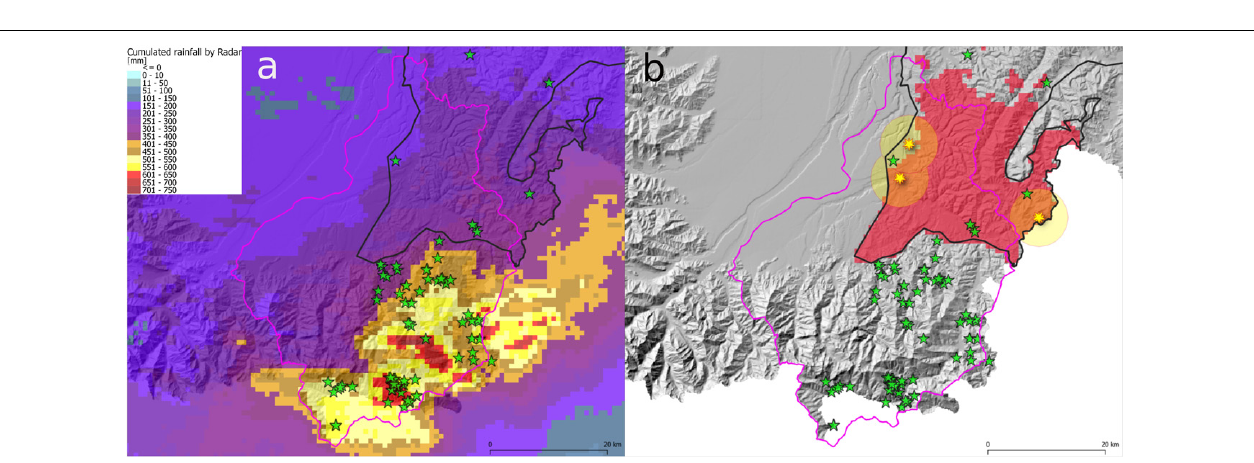
FIGURE 7 | (a) Accumulated rainfall from 24th November at 15:00 UTC in Alto Tanaro. (b) In red, areas interested by precipitations that overpassed thresholds of Equation 4 (critical rainfall accumulations); green star labels indicate occurred landslides.